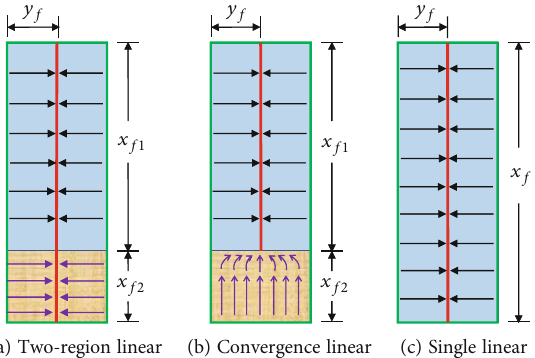
Figure 2: Schematic of the typical fl ow models for analyzing the in fi ll well-caused fracture